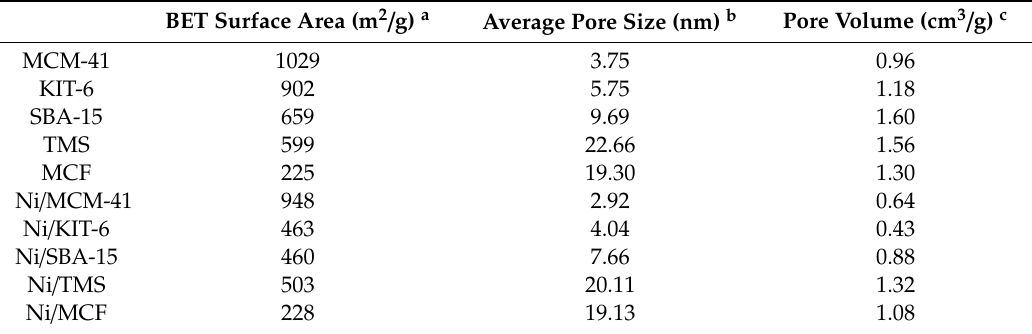
Table 2. Textural properties of the silica materials in Ni / SiO 2